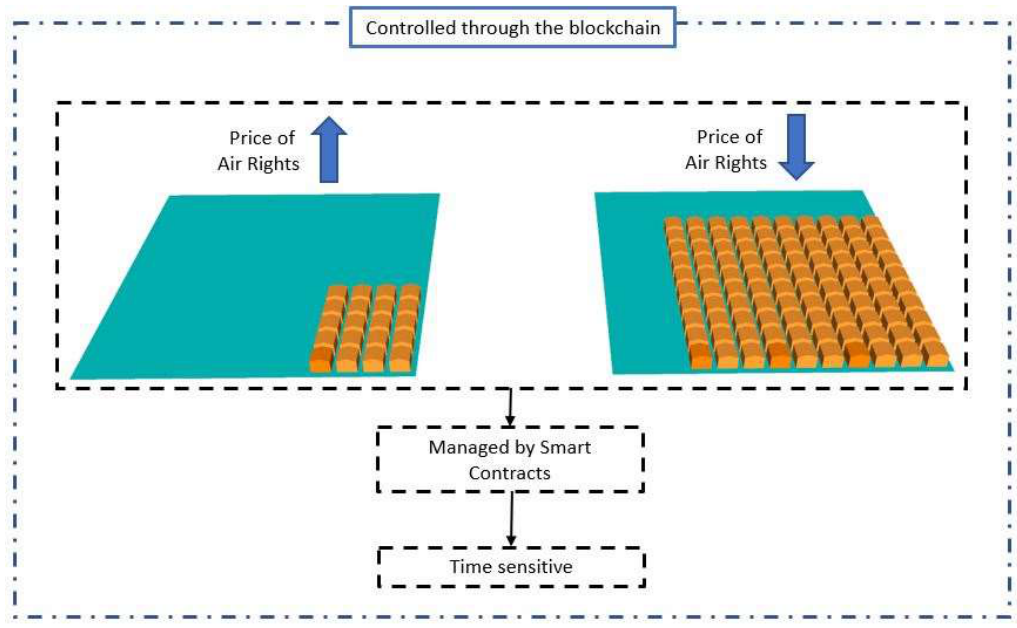
Figure 1. Proposed model for time-sensitive air rights trading through Smart Contracts (illustration sourced by authors).